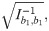
Variance components of b1 vs. b1.Subfigure (a) shows the change of Ib1,b1−1, the naïve standard error of b1, with respect to b1. Subfigure (b) shows the change of (IZ1−1MCov(X1|Z1)MTIZ1−1)b1,b1 with respect to b1. In our current method, both are fixed, with values calculated at θ^.